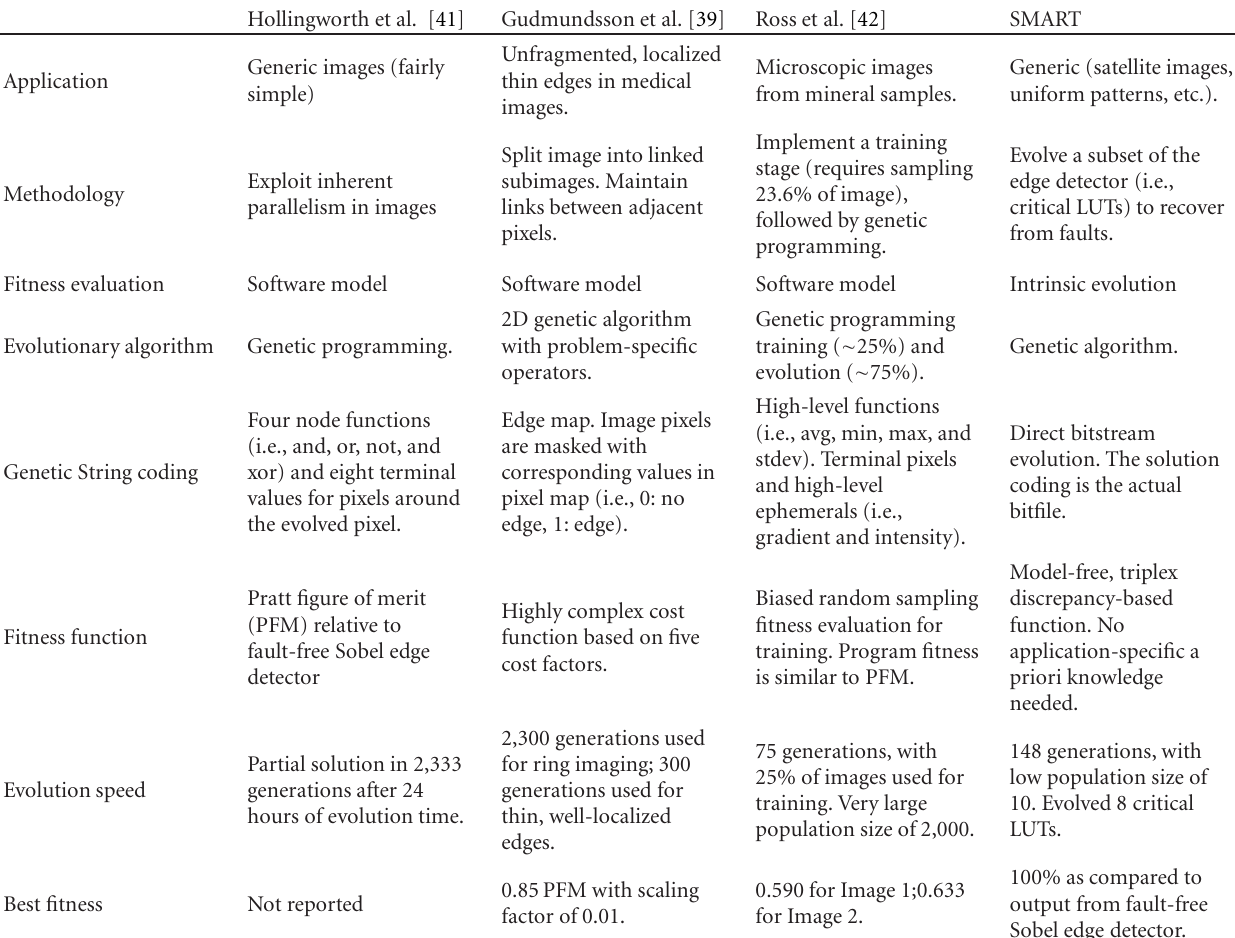
Table 10: Comparison of the RARS prototype and three other edge-detection evolution